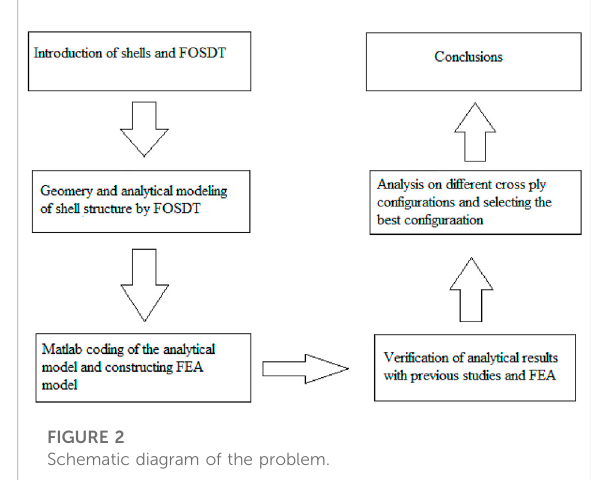
FIGURE 2 Schematic diagram of the